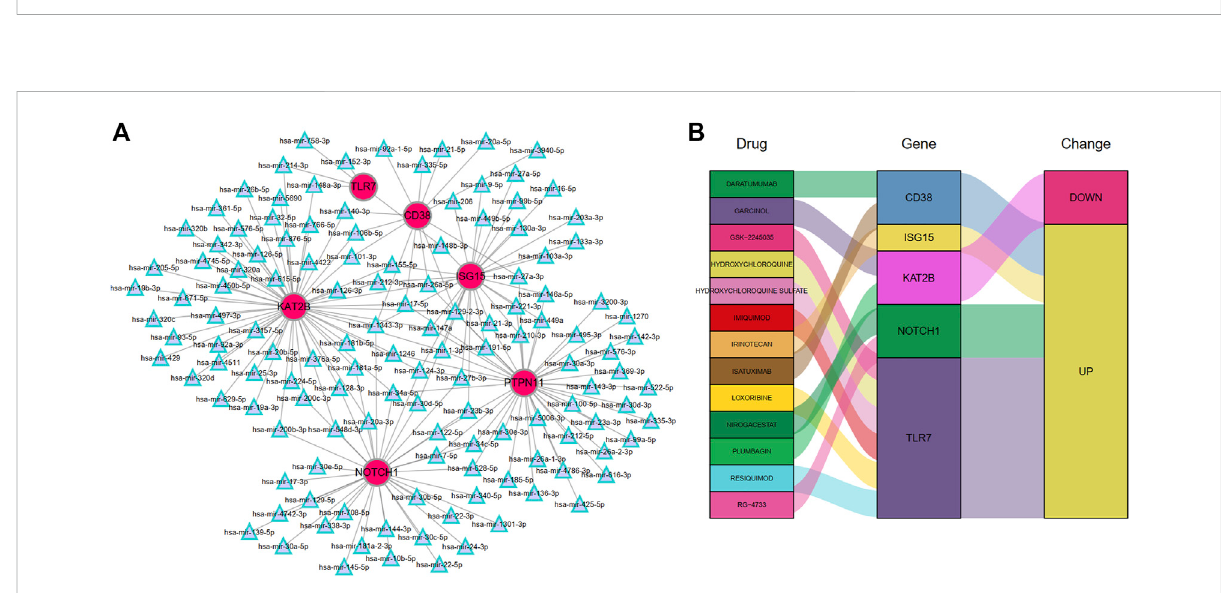
FIGURE 10 The miRNA-Genes regulatory network (A) and Drug-Genes interactions (B)